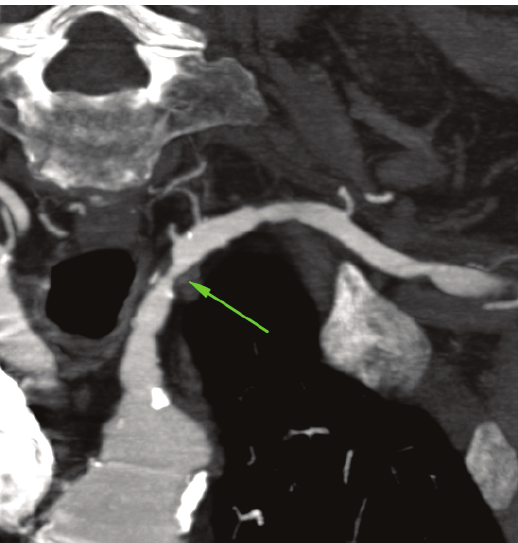
Figure 2: Computed Tomography Angiography (MPR reconstruction): proximal stenosis of the left subclavian artery (arrow).